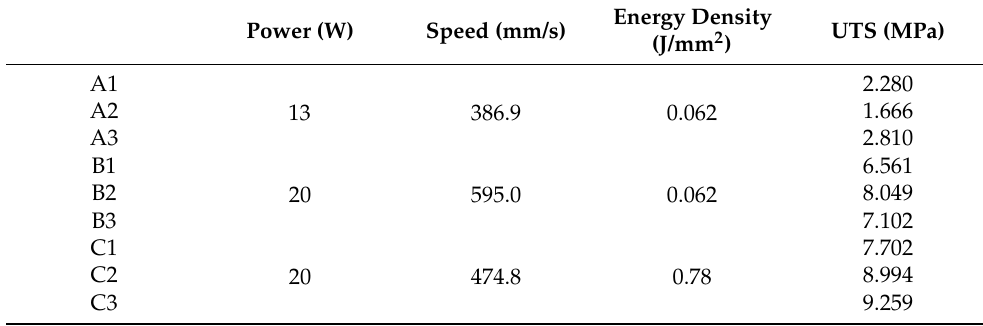
Table 1. Process conditions and tensile strength results of the multi-layered